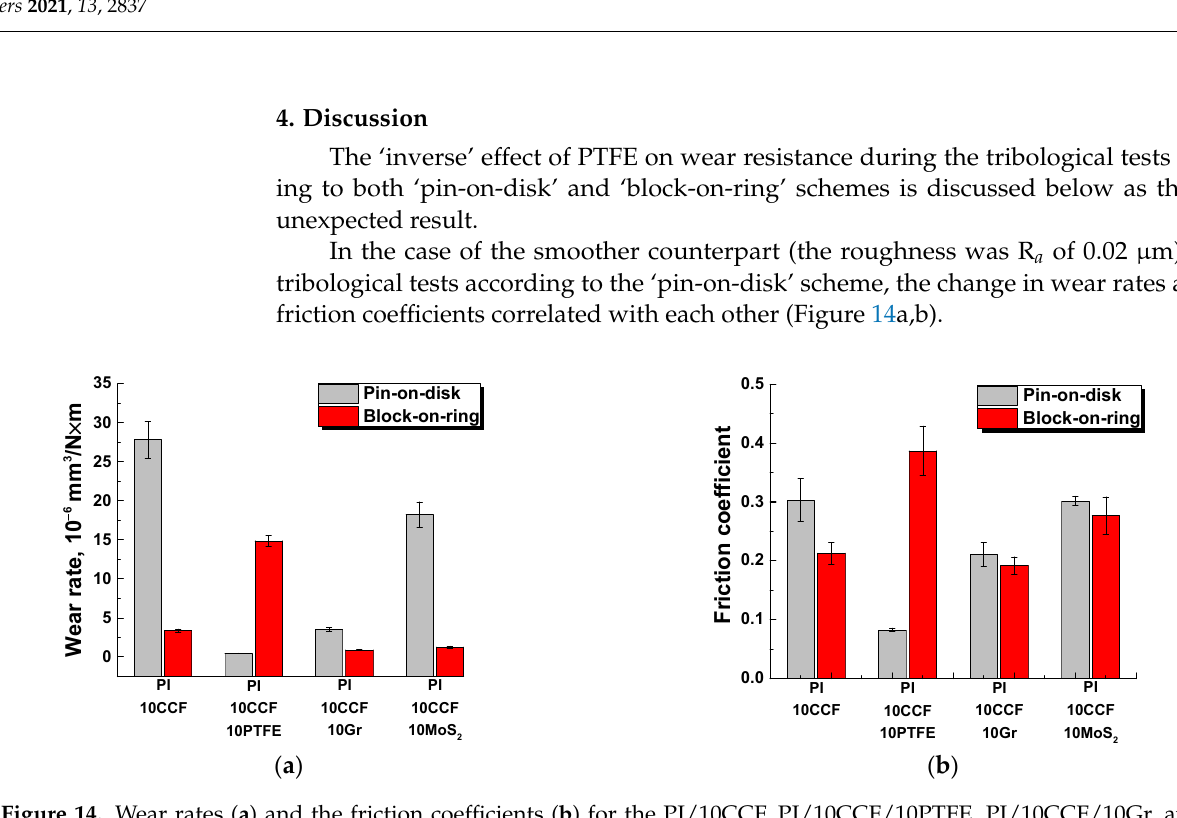
Figure 14. Wear rates ( a ) and the friction coefficients ( b ) for the PI/10CCF, PI/10CCF/10PTFE, PI/10CCF/10Gr, and PI/10CCF/10MoS 2 composites at P = 5 N and V = 0.3 m/s for the ‘pin-on-disc’ scheme as well as P = 180 N and V = 0.3 m/s for the ‘block-on-ring’ one.